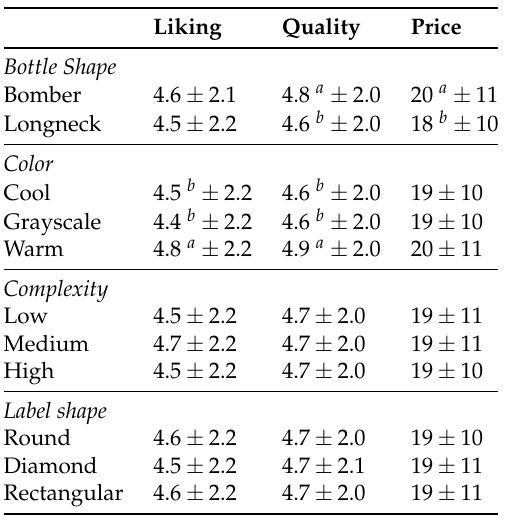
Table 3. Means and standard deviations for individual levels of each design factor. Different superscript letters indicate significant differences between means following pairwise comparisons (Tukey p <